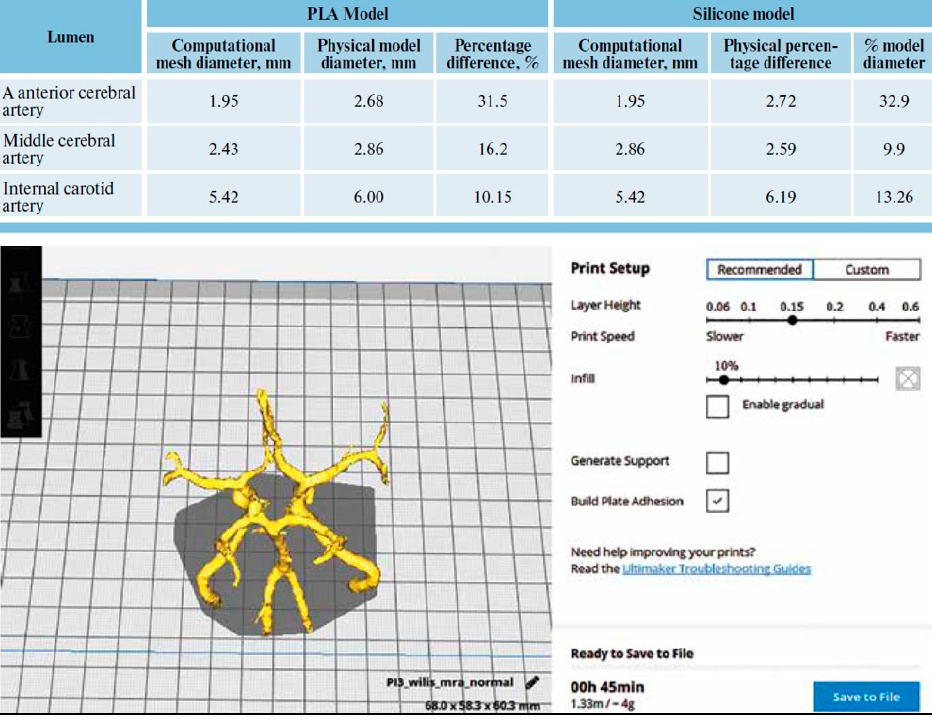
Figure 5. The vasculature surface model edited at the clinical workstation to remove rendering artifacts and crop any undesired vessels.